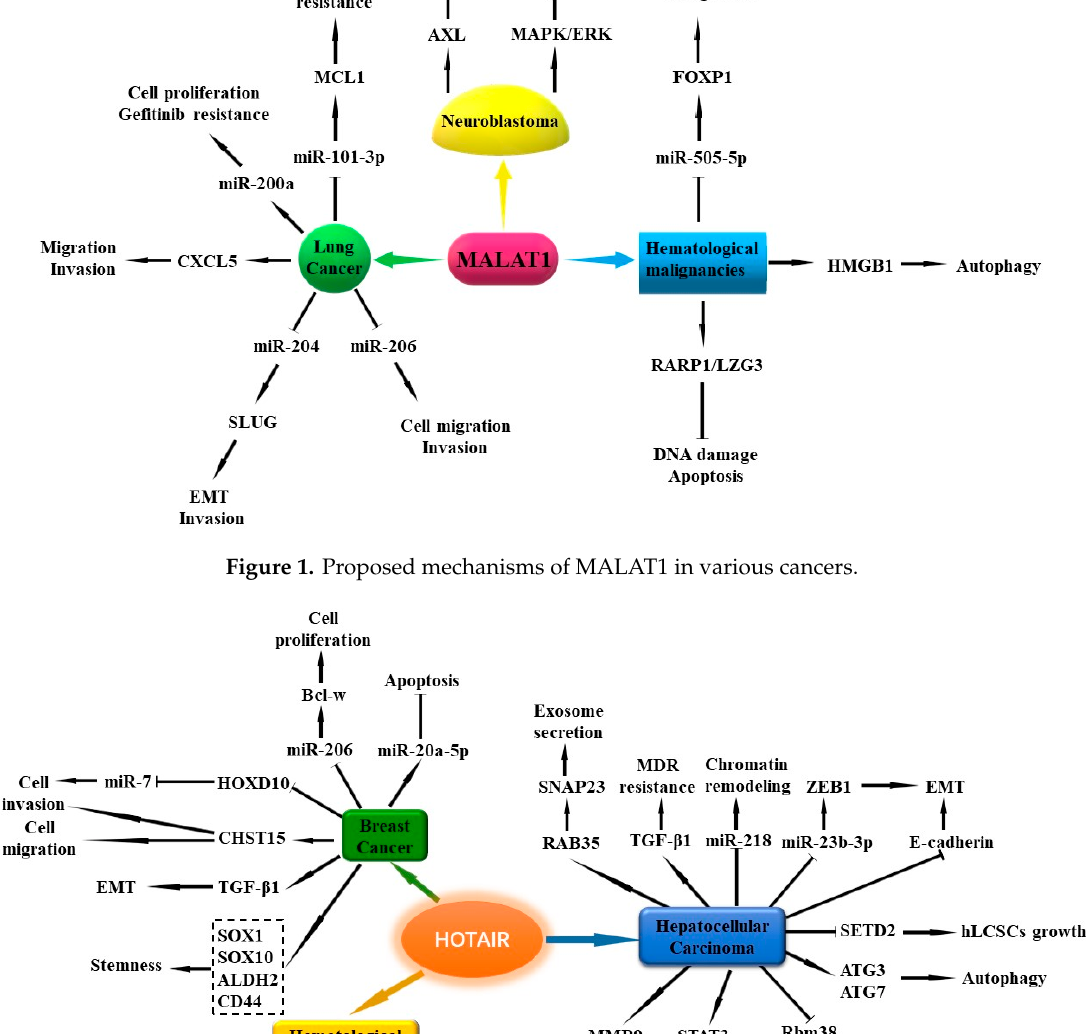
Figure 2. Proposed mechanisms of HOTAIR in various cancers .